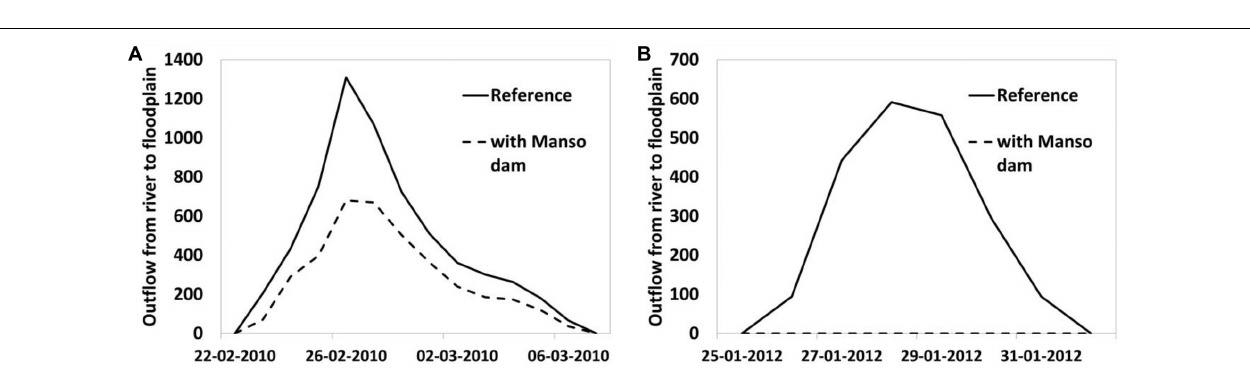
FIGURE 5 | Outflow hydrographs from river to floodplain along the reach of the Cuiabá river between Cuiabá (point 2) and Barão de Melgaço (point 3) in the reference (no dam) and altered (with dam) scenarios: (A) wet year (2010); (B) dry year (2012).